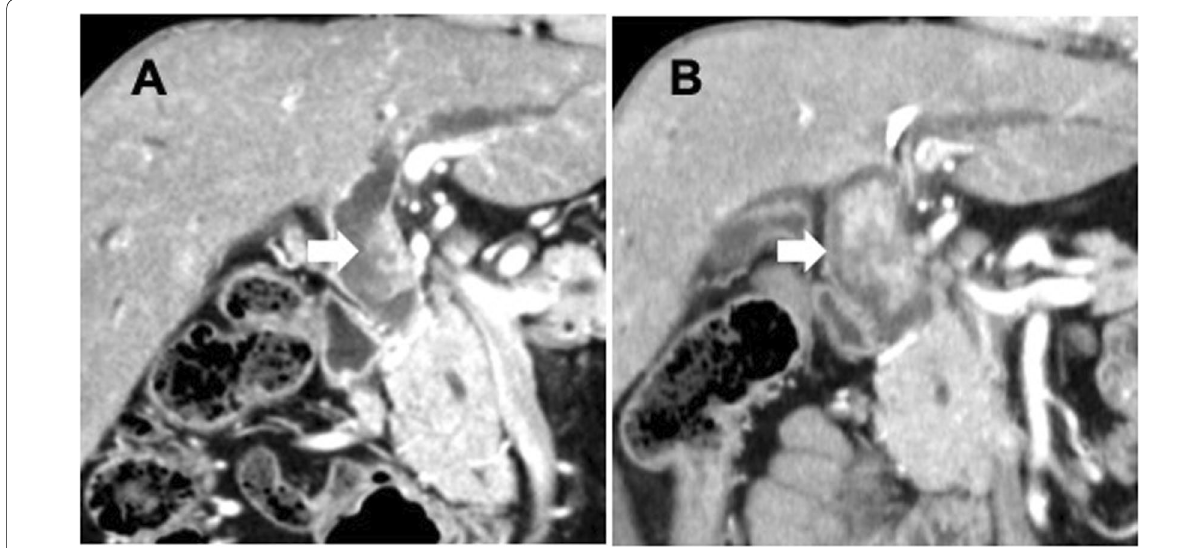
Fig. 1 Computed tomography images at presentation showed a nodular mass at the common hepatic duct ( A ). Imaging before surgery showed rapid tumor growth ( B )